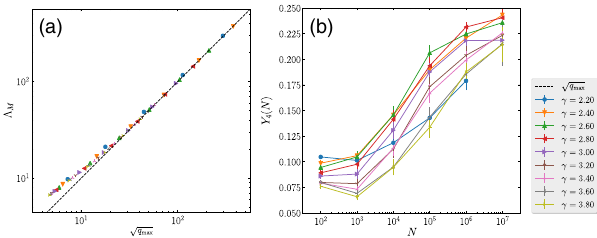
ffiffiffiffiffiffiffiffiffi p q as a function of in M max